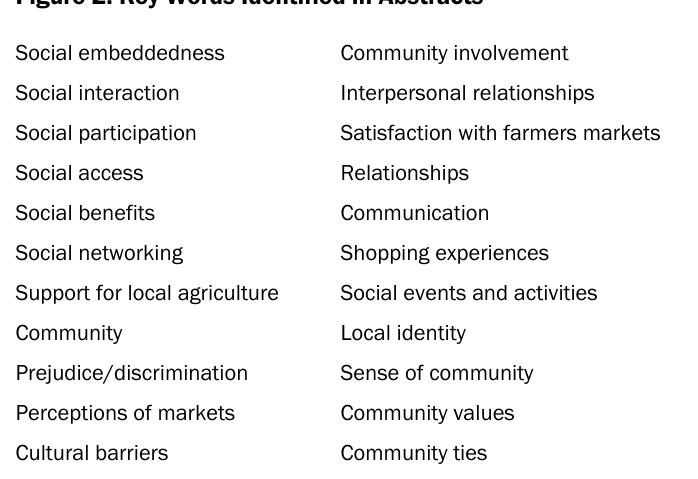
Figure 2. Key Words Identified in